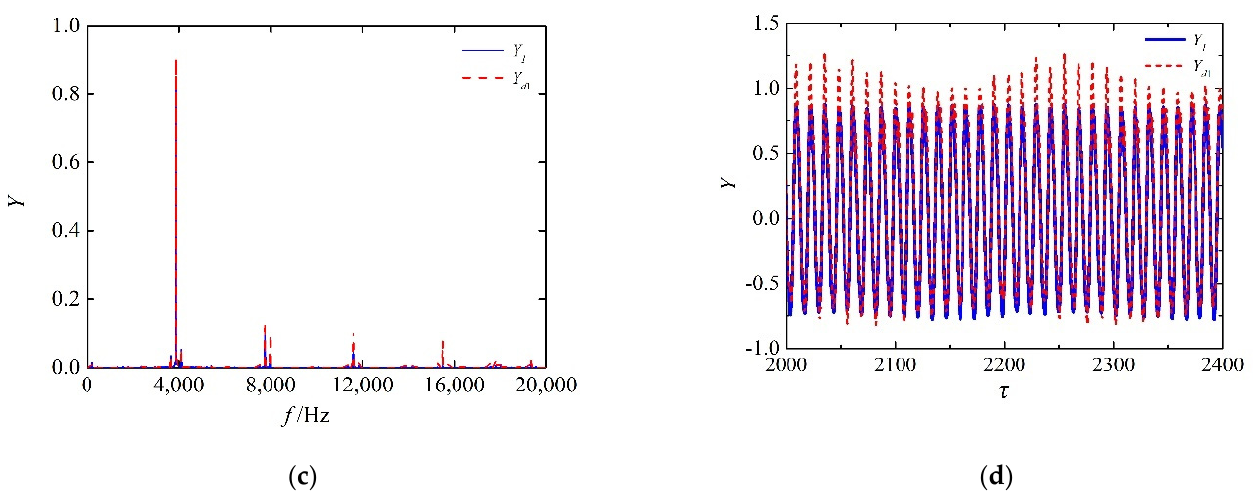
Figure 9. Quasiperiodic motion of the rod – fastened rotor at ω = 2500 rad/s: ( a ) orbit and Poincaré map at the left bearing station; ( b ) orbit and Poincaré map at the left disk station; ( c ) comparison of spectrogram at the left disk and left bearing stations; ( d ) comparison of the time series diagram at the left disk and left bearing stations.